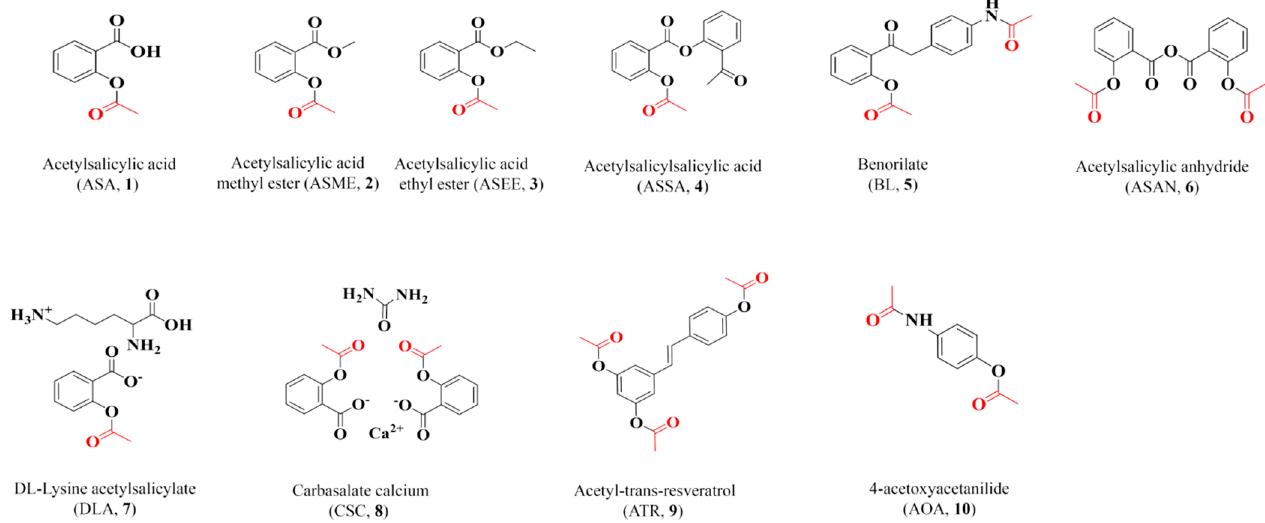
Figure 1. Chemical structures of the acetyl donor candidates.